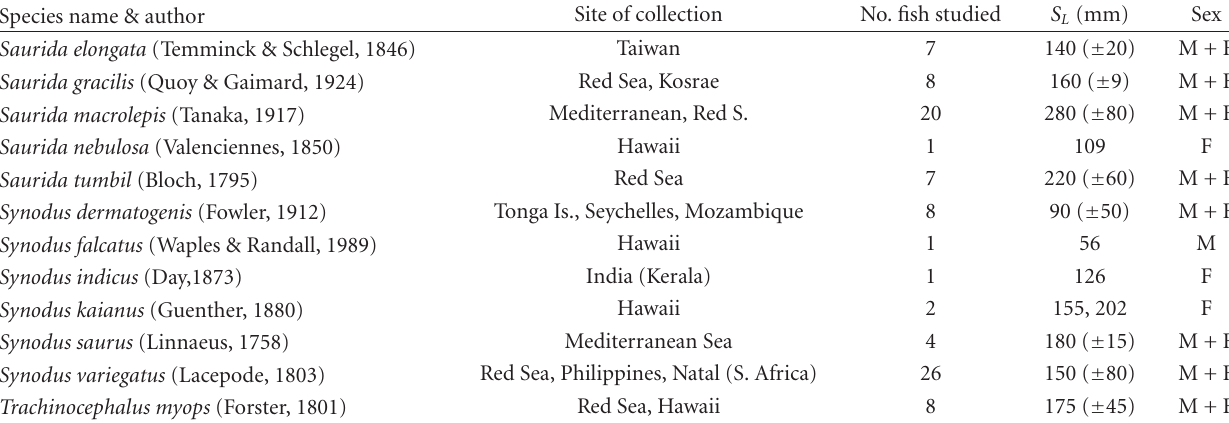
Table 1: Lizardfishes studied, locality of origin, and standard length ( S L + SD